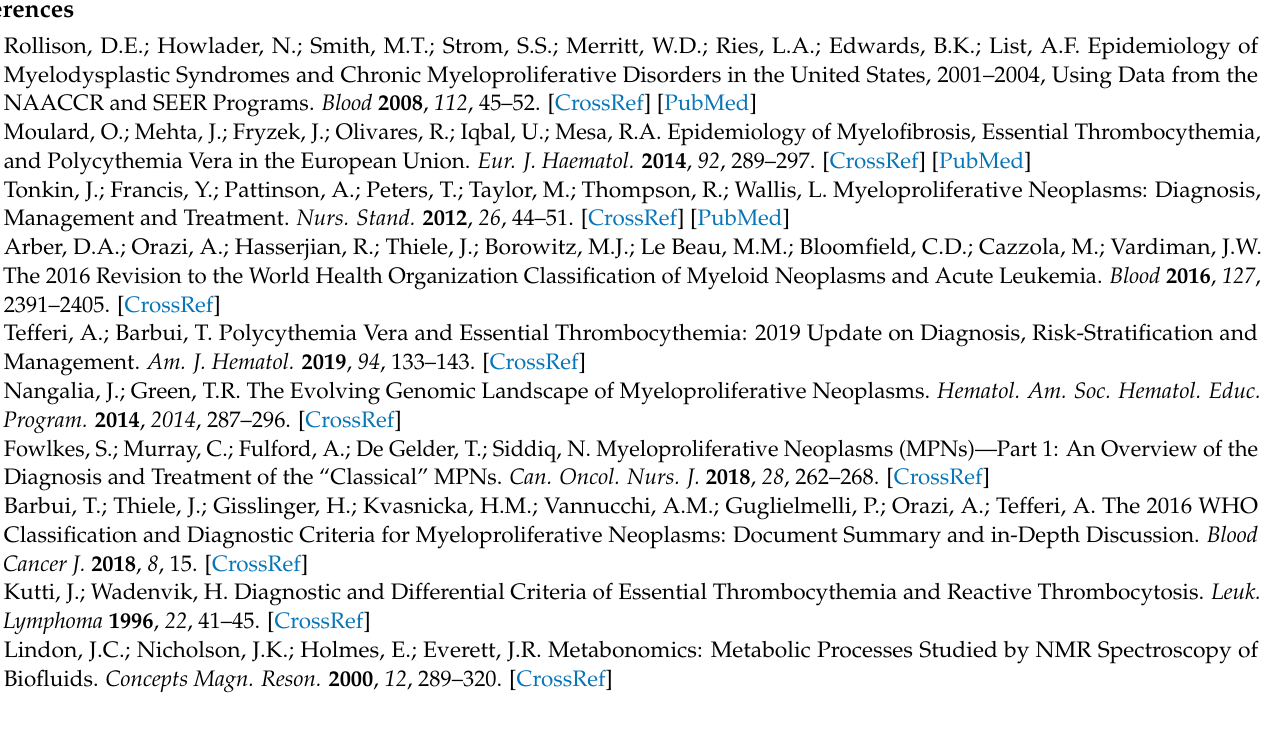
the study; Figure S1: principal component analysis (PCA) score plots corresponding to the samples included in the study; Figure S2: OPLS-DA scores plot for the comparison between HC vs. ET + PV; Figure S3: SUS-plot analysis correlating the OPLS-DA models of HC vs. PV ( x -axis) and HC vs. ET ( y